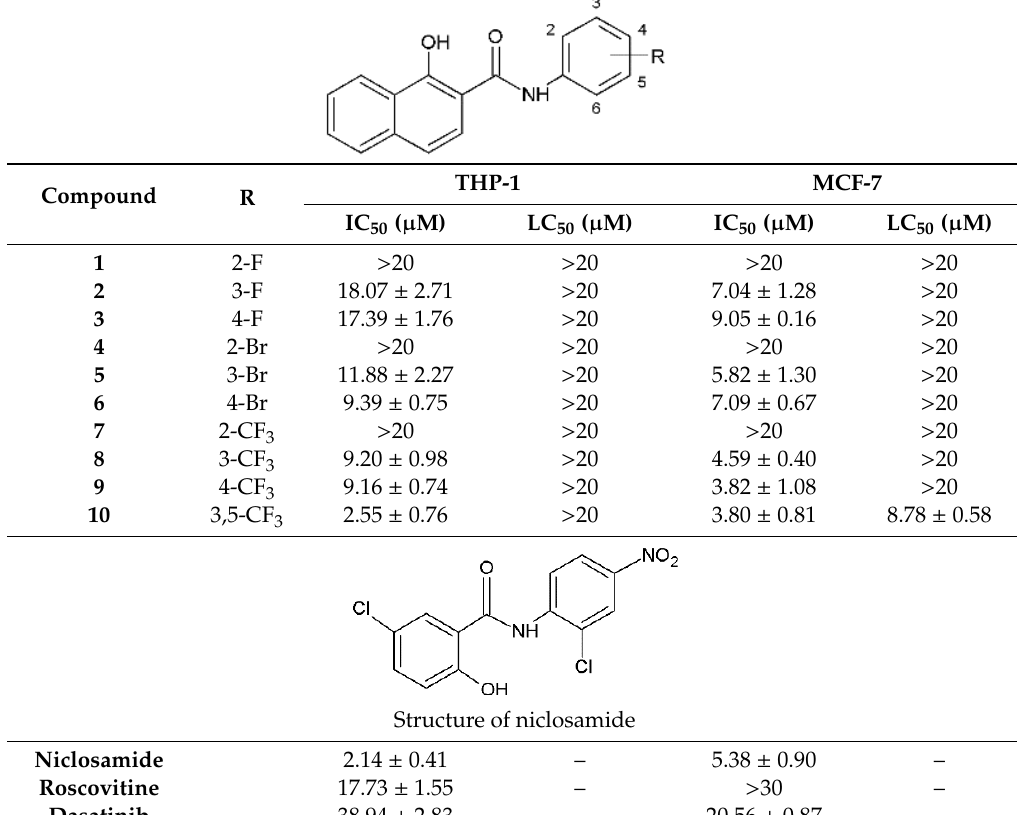
Table 1. Antiproliferative and cytotoxic activities of ring-substituted 1-hydroxynaphthalene-2- carboxanilide derivatives. Cell proliferation and viability were determined using WST-1 analysis and erythrosin B exclusion test, respectively, after 24 h incubation with serial dilutions of tested compounds. Values shown are the mean ± SD from three independent experiments, each performed in triplicate.